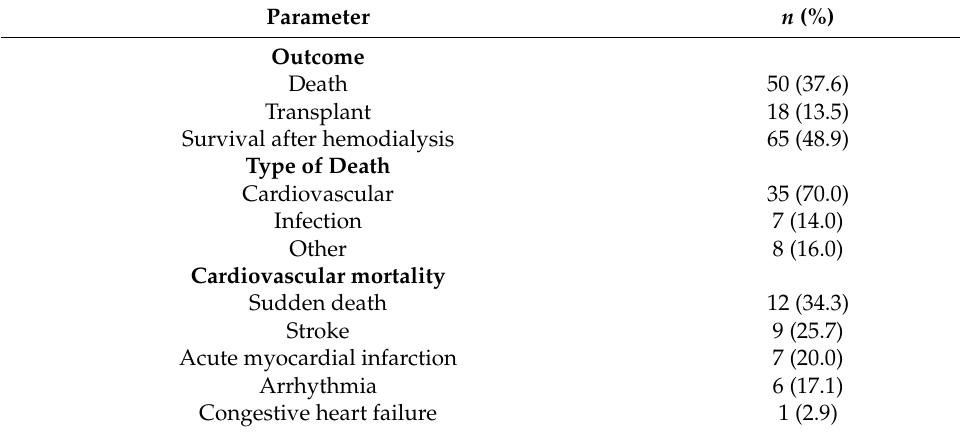
Table 3. Outcomes observed over 78 months in the sample studied ( n = 133).